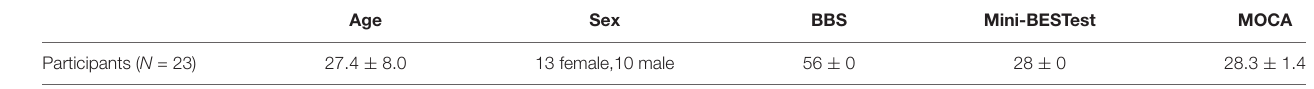
TABLE 1 | Demographic and clinical characteristics. Age Sex BBS Mini-BESTest MOCA